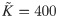
ALC can slow down the convergence to extinction of small deterministic populations.The black curve corresponds to the production function of the uncontrolled Model (1) with r = 4.5, K˜=400 and s = 0.002, and the red curve to the population controlled by ALC with intensity c = 0.5.